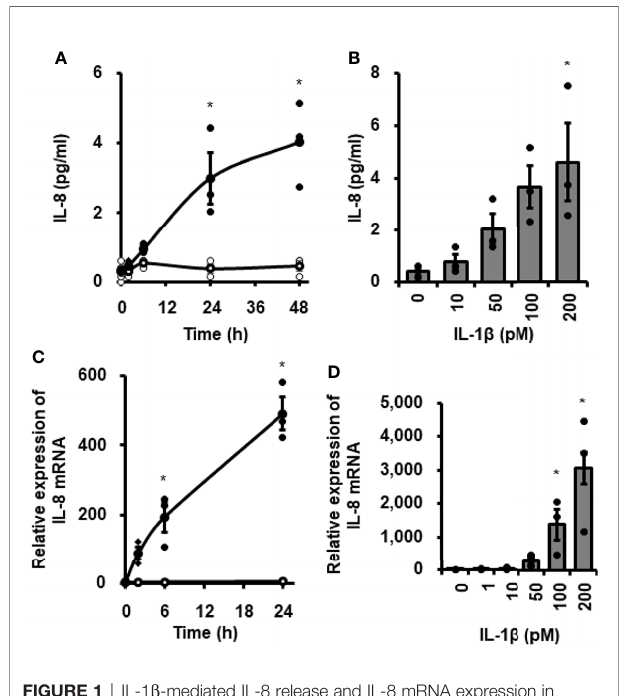
FIGURE 1 | IL-1 b -mediated IL-8 release and IL-8 mRNA expression in canine cardiac fi broblasts. Time-dependent increase in IL-8 protein release (A) and IL-8 mRNA expression levels (C) in fi broblasts treated with (closed circle) or without (open circle) canine recombinant IL-1 b (100 pM). Dose- dependent IL-8 protein release (B) and IL-8 mRNA expression levels (D) in fi broblasts treated with the indicated concentrations of IL-1 b for 24h. HRPT1 was used as an internal standard and the expression levels of IL-8 mRNA in IL-1 b -stimulated fi broblasts were compared with the expression at 0h. Results have been represented as mean ± standard error (SE) from biological triplicates. *P <0.05.